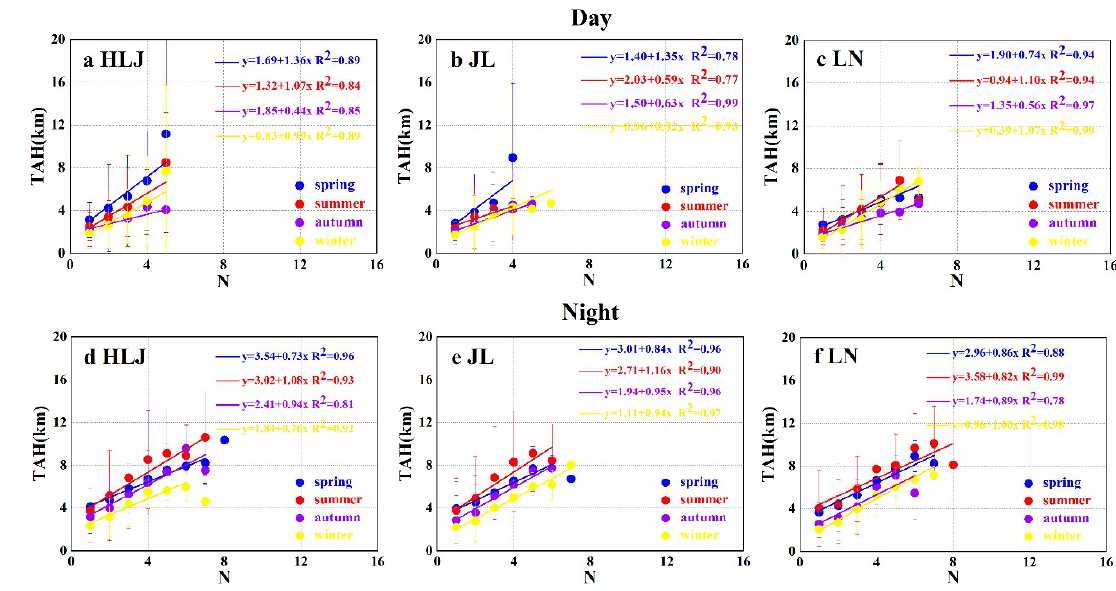
Figure 11. The correlation between TAH and N over NEC. Where, ( a , d ) represent HLJ, ( b , e ) represent JL, and ( c , f ) represent LN.